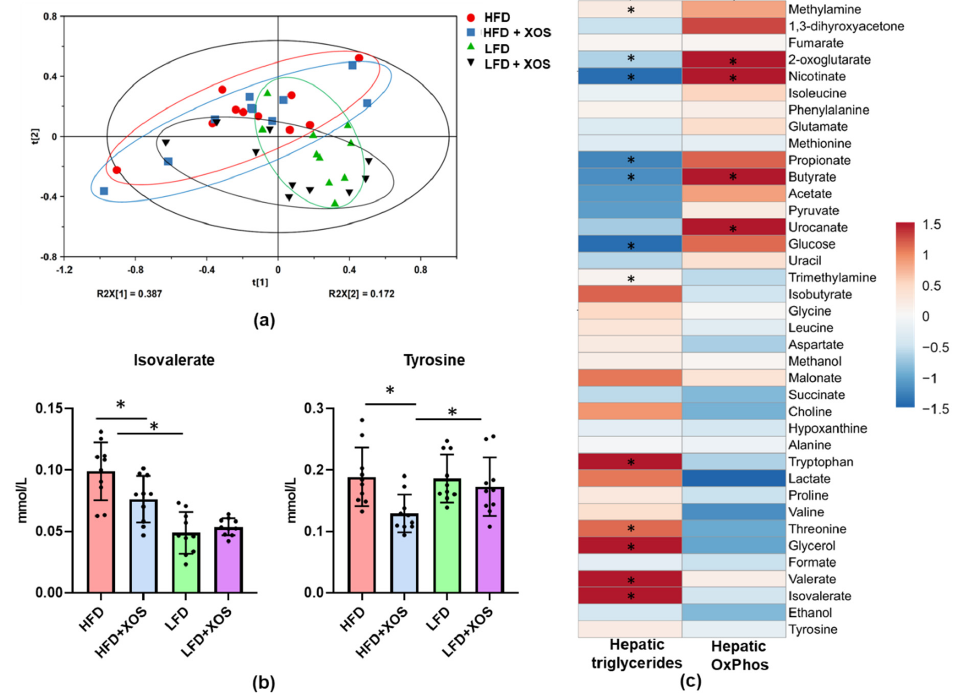
Figure 10. XOS decreased the levels of cecal tyrosine and isovalerate on the HFD. ( a ) The score scatter plot of the Principal Component Analysis (PCA) of the cecal metabolites showed no major differences between the diet groups. n = 10/diet group; ( b ) The levels of cecal tyrosine and isovalerate differed between the diet groups. n = 10/diet group. The different data points are shown with black dots. * indicates significant difference between the groups; ( c ) The associations of the metabolites with the hepatic triglyceride content and oxidative phosphorylation. n = 10/diet group. The heatmap was drawn using Clustvis, which is a web tool used to visualize clustering of multivariate data (https://biit.cs.ut.ee/clustvis/). However, the clustering is not shown here. * indicates significant association between the variables. The colored scale bar for the associations is shown on the right, and the color corresponds to the value of Spearman’s correlation coefficient. Table 1. The concentrations of SCFA (mM, mean ± SEM) and acetate (A): propionate (P): butyrate (B) ratio in the cecum of the rats.